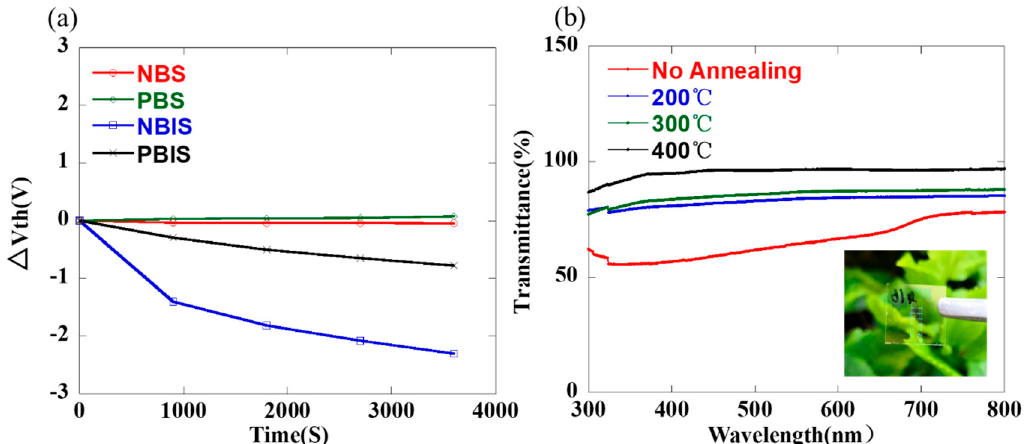
Figure 6. ( a ) Variations of V th at the applied NBS time, NBIS time, PBS time and PBIS time, respectively. ( b ) Optical transmittance spectra of fabricated devices at different post ‐ annealing temperature, no annealing, 200 °C, 300 °C, and 400 °C, respectively. The inset is the devices post annealed at 400 °C.